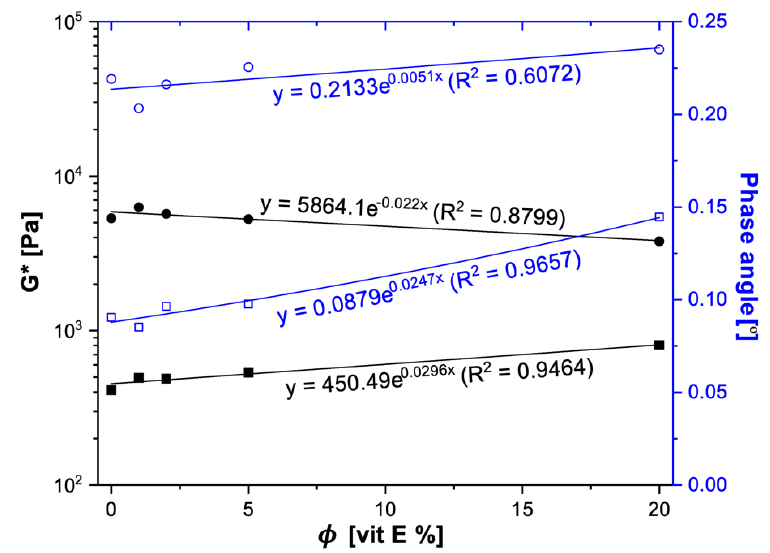
Figure 2. Frequency sweep measurements results for formulations with 12HSA:VO ( • ) and CW:VO ( ■ ) in terms of G* (closed symbols) and the phase angle (open symbols) at 1 Hz. The experimental data are represented by symbols, and the fitting model is represented by lines according to the percentage of VE available ( Φ).